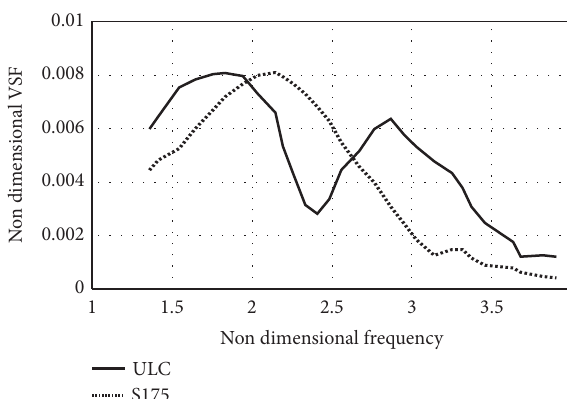
Figure 14: Shear force RAO comparison between S175 and the ULC ( F